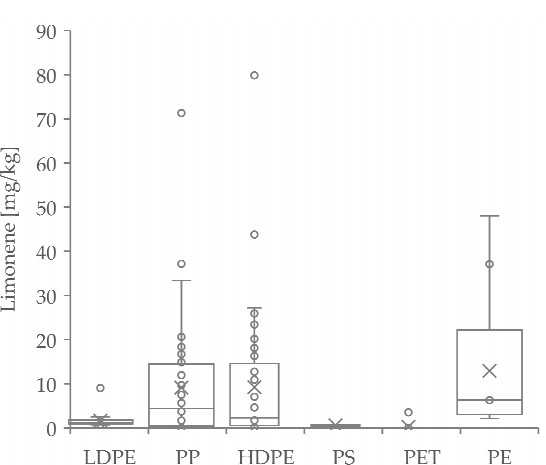
Figure 3 . Quantification of additives Irgafos 168; oxidized Irgafos 168; Irganox 245; Irganox 1010; Irganox 1076 and Irganox 1330 ( a – f ) in different types of polymers. (× = Mean, ° = Outlier).